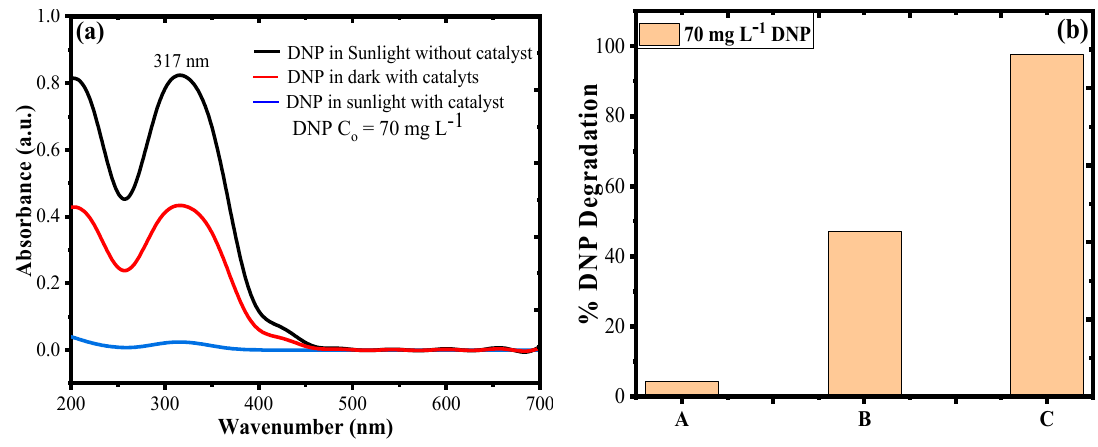
Figure 10. ( a ) UV–Vis plot; and ( b ) degradation rate of DNP in direct solar irradiation without catalyst (photolysis, A), dark with catalyst (B), and direct solar irradiation with catalyst (C) for an aliquot of 20 mL of 70 mg L − 1 DNP under optimized reaction conditions.